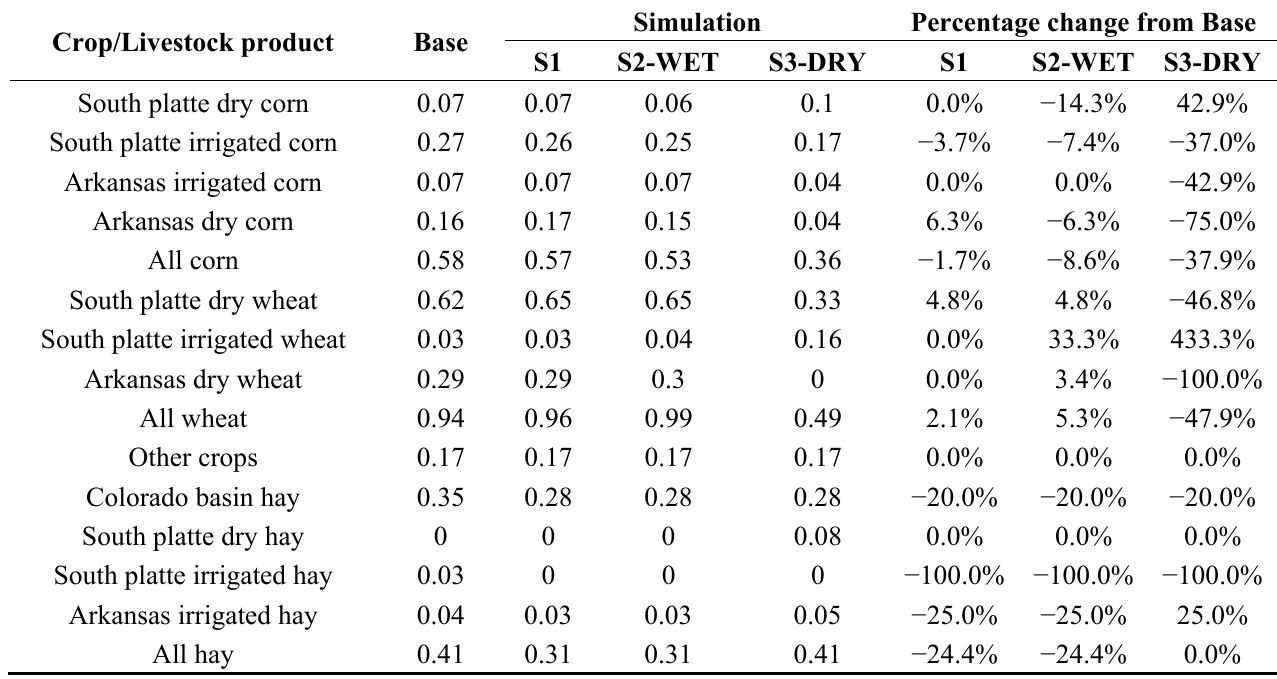
Table 3. Area harvested in Base scenario and Climate Change